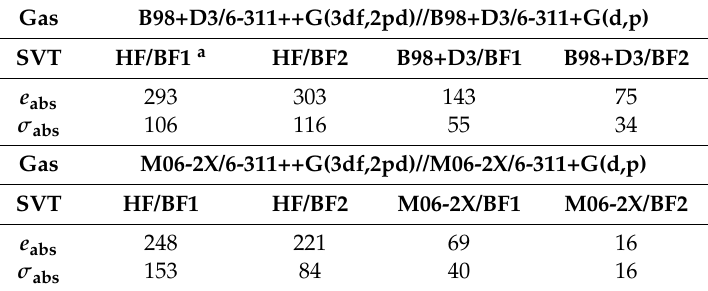
Table 4. Mean absolute errors ( e abs ) and standard deviation of absolute errors ( σ abs ) for theoretical values of 12 investigated nitroaromatic MBHA calculated at DFT level with C-PCM continuum solvation model from indirect protocol. Values are in